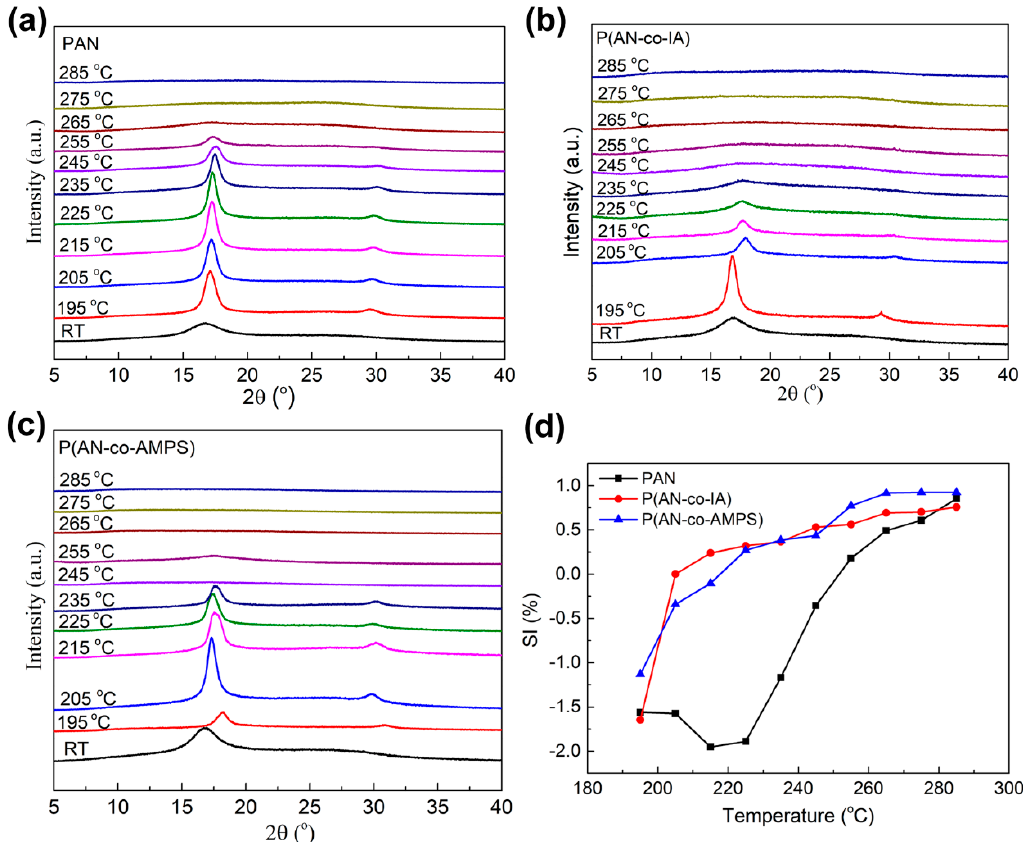
Figure 7. XRD patterns of ( a ) PAN, ( b ) P(AN-co-IA), and ( c ) P(AN-co-AMPS) nanofibers stabilized at different temperatures. ( d ) SI of PAN, P(AN-co-IA), and P(AN-co-AMPS) nanofibers at different temperatures.